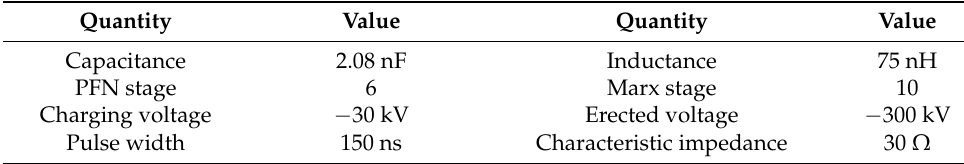
Table 2. Design parameters of the 10-stage PFN–Marx generator.